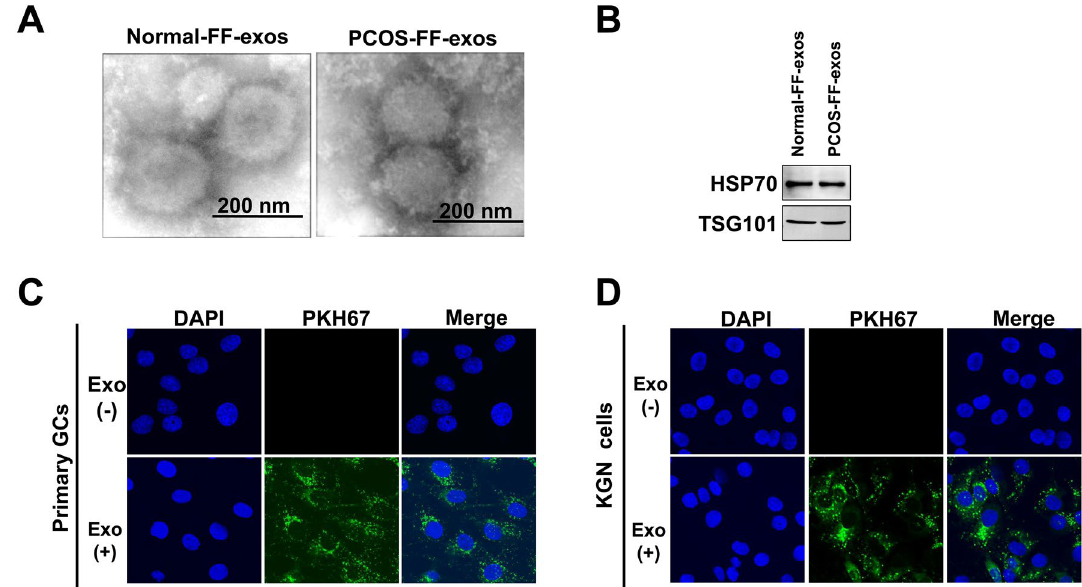
Figure 1. Isolation and identification of exosomes derived from human follicular fluids. (A) Transmission electron microscopy (TEM) analysis of the ultrastructure of exosomes from the FF of the normal population (normal-FF-exos) and the exosomes from the FF of patients with PCOS (PCOS-FF-exos). Scale bars, 200 nm. (B) Western blotting analysis of the exosome markers HSP70 and TSG101. Original blots/gels are presented in Supplementary Fig. S3. (C) Detection of FF-exosome uptake by primary GCs or KGN cells in vitro. Granulosa cells were incubated with PKH67-labeled exosomes for 12 h (PKH67 is shown in green, nuclei were stained with